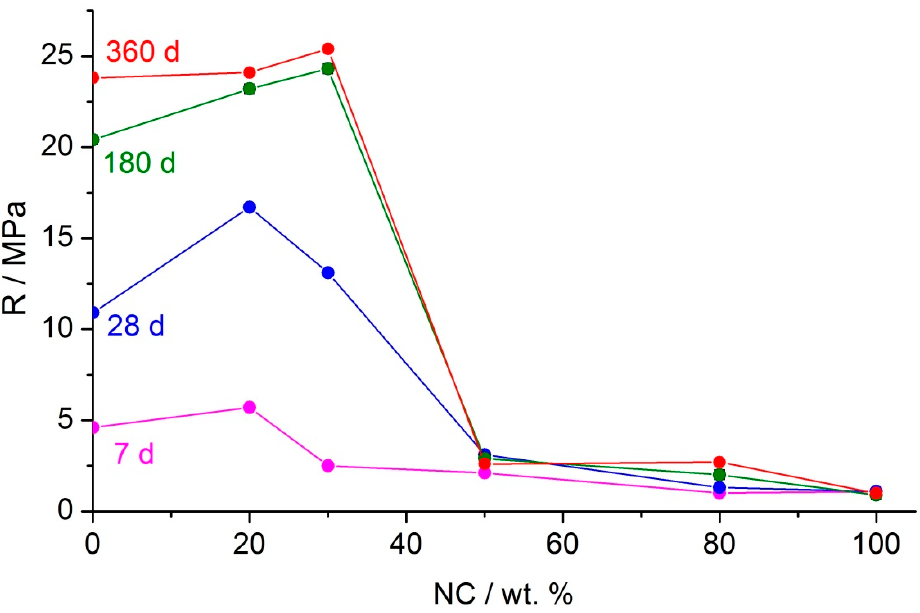
Figure 3. Compressive strength (R) of the NC–Cu–Ni slag–water binder at 7, 28, 180, and 360 days of age as a function of percentage mass of the NC in the mixture NC–Cu–Ni slag mechanically activated in CO 2 . Reproduced with permission from [47], published by Prospective Materials, 2015.